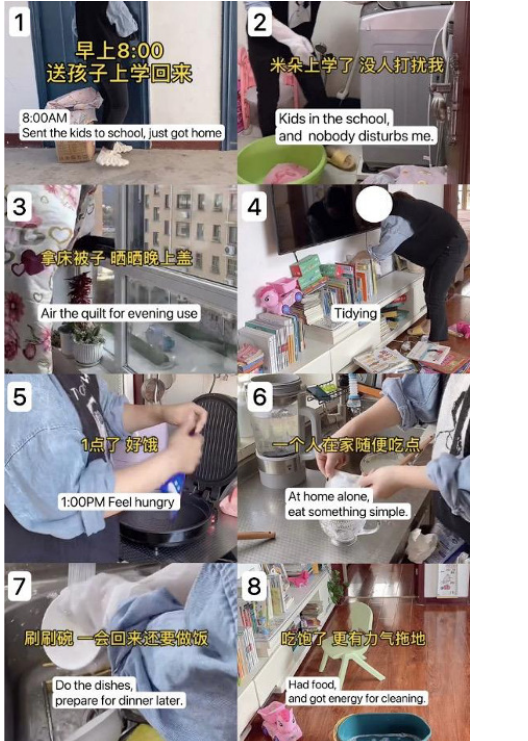
Figure 5. Timeline of Jiajia’s cleaning